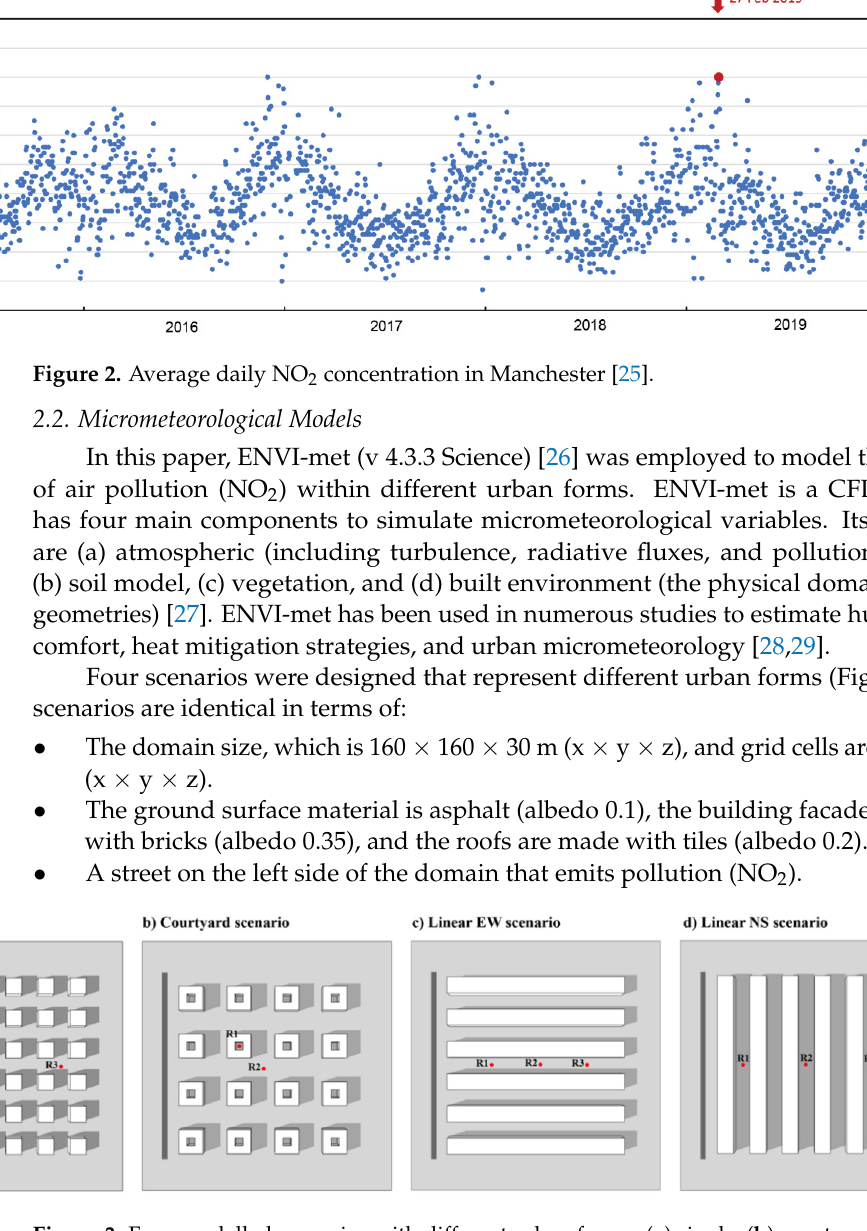
Figure 3. Four modelled scenarios with different urban forms: ( a ) single, ( b ) courtyard, ( c ) linear EW, and ( d ) linear NS.